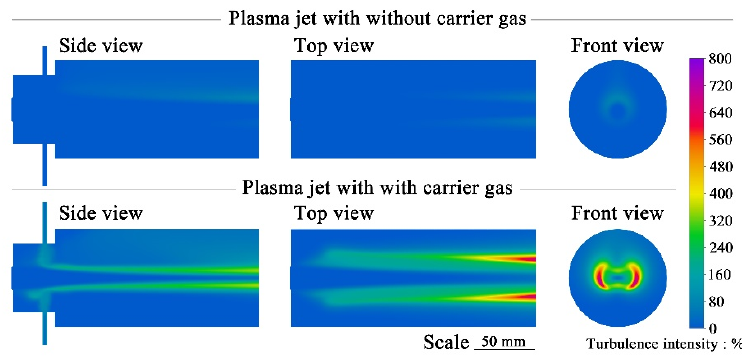
Figure 10. Turbulence intensity distribution of plasma jet with carrier gas.